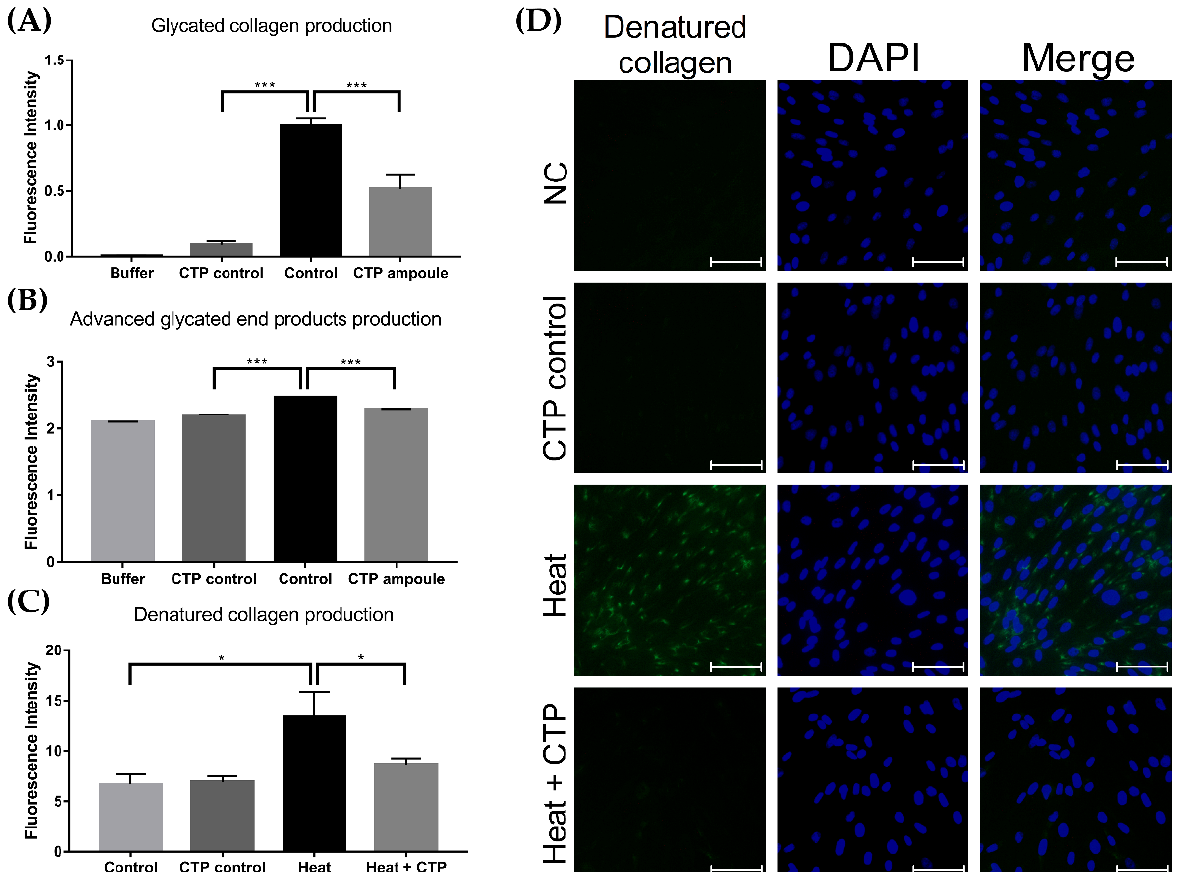
Figure 9. Effect of the CTP ampoule on glycated collagen, AGE, and denatured collagen production. Glycated collagen and AGE production decreased in the CTP ampoule treatment group compared to the control group ( A , B ). Denatured collagen production induced by heat treatment decreased with CTP ampoule treatment ( C ), as visually shown in ( D ); * p < 0.05, *** p < 0.005, independent samples t -test. Scale bar indicates 80 µ m. CTP ampoule, Ever Collagen Corrector Collagen Tripeptide Ampoule; AGEs, advanced glycated end products.